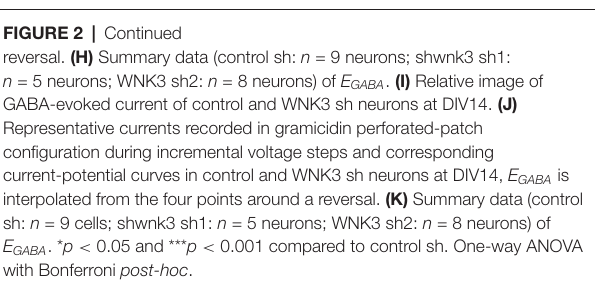
FIGURE 2 | Continued reversal. (H) Summary data (control sh: n = 9 neurons; shwnk3 sh1: n = 5 neurons; WNK3 sh2: n = 8 neurons) of E GABA . (I) Relative image of GABA-evoked current of control and WNK3 sh neurons at DIV14.